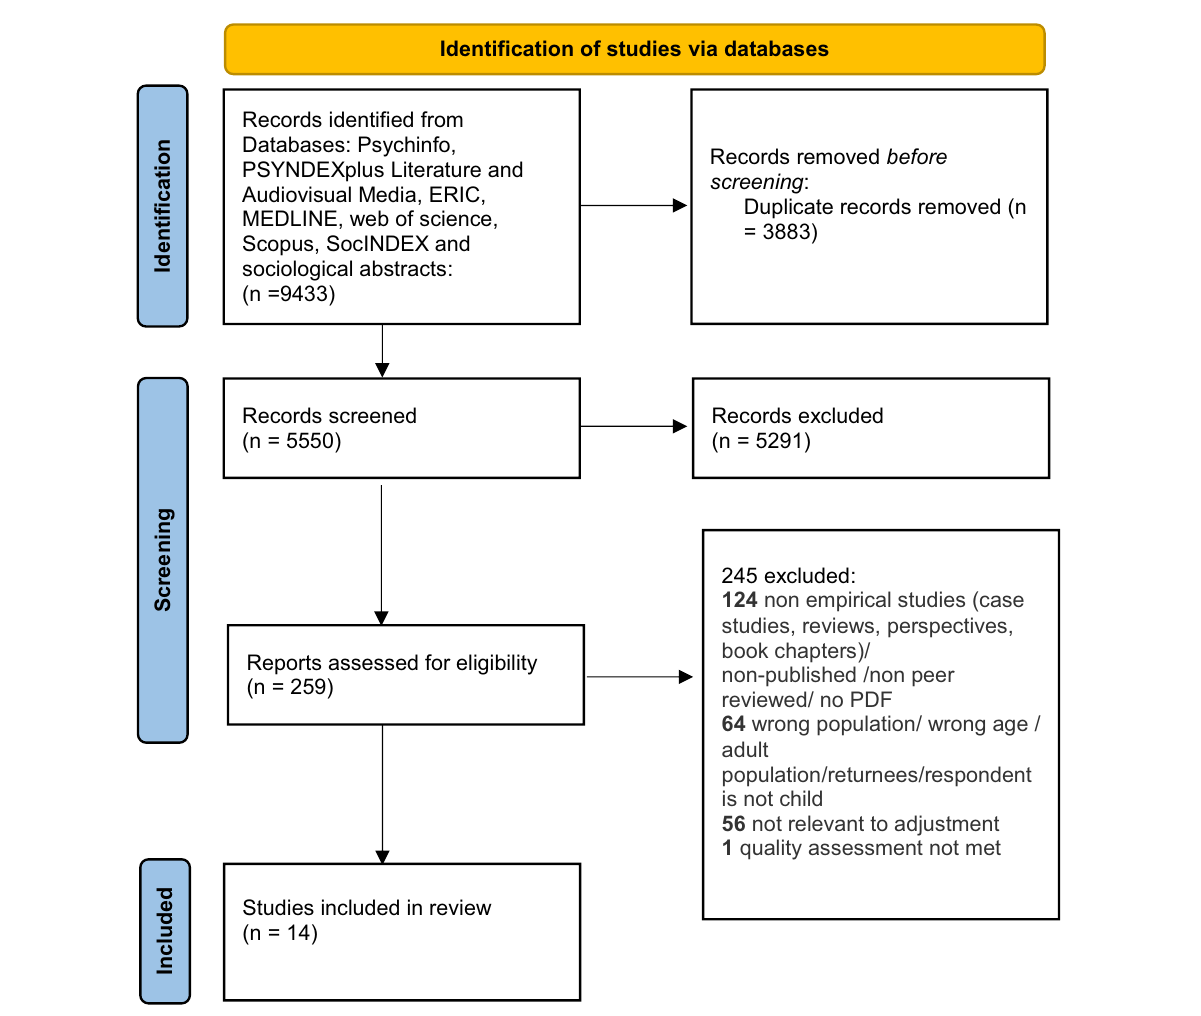
FIGURE1 PRISMA 2020 flow diagram for new systematic reviews which included searches of databases and registers only. From Page et al. (2021). For more information, visit: